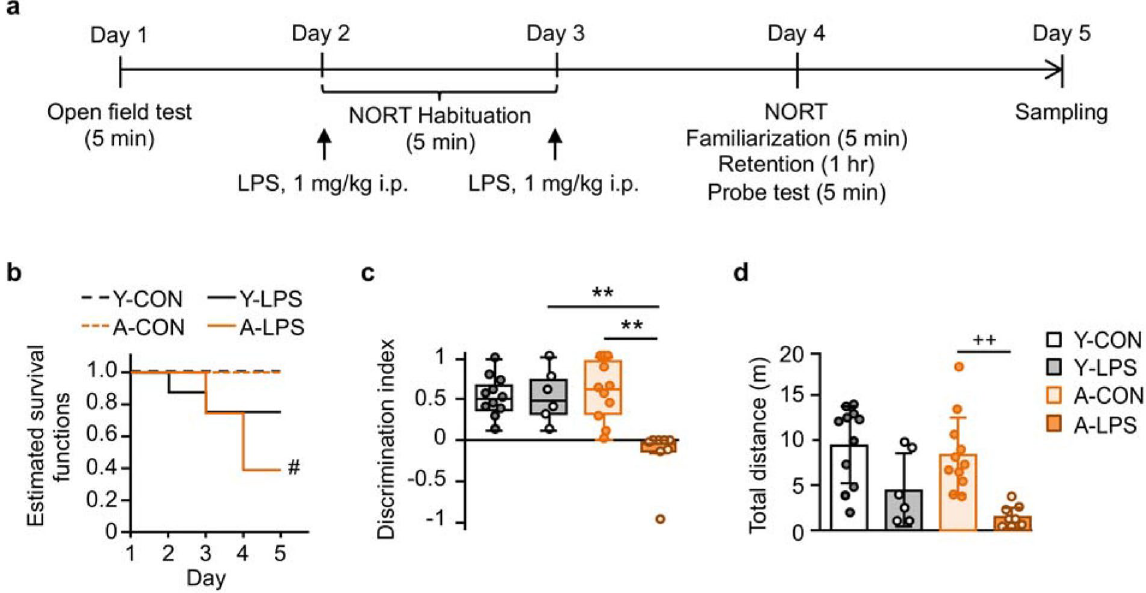
Figure 1. Dual lipopolysaccharide (LPS) challenge induced lethal sepsis and object discrimination impairment in aged rats. ( a ) Schematic representation of the experimental protocol. Young and aged rats were assigned to control or 1 mg/kg LPS intraperitoneal injection groups after being subjected to the open field test (Y-CON group, n = 11; A-CON group, n = 11; Y-LPS group, n = 8; A-LPS group, n = 20). Y-LPS and A-LPS group rats were administered LPS after each novel object recognition test (NORT) habituation session. On Day 4, survivor rats were subjected to the NORT. ( b ) The Kaplan–Meier survival curves showed that the survival rate of the A-LPS group was significantly lower than that of the A-CON group. ( c , d ) In the NORT, the discrimination index and locomotor activity of the A-LPS group were significantly reduced compared with those of the A-CON group. There were no significant differences in the survival rate and the NORT performance between Y-CON and Y-LPS groups. The behavioral data are presented as the median ± IQR or mean ± SD. Y-CON, n = 11; Y-LPS, n = 6; A-CON, n = 11; A-LPS, n = 8. Log-rank test with Bonferroni correction, # P < 0.05, A-CON vs. A-LPS; permuted Brunner-Munzel test with Bonferroni correction, **P < 0.01, effect size p ̂ ≥ 0.96; Welch’s ANOVA [F 3,14.1 = 17.7, P < 0.001, ω 2 = 0.73] and post-hoc Bonferroni corrected Welch’s t -test, ++ P < 0.01, Hedge’s g =